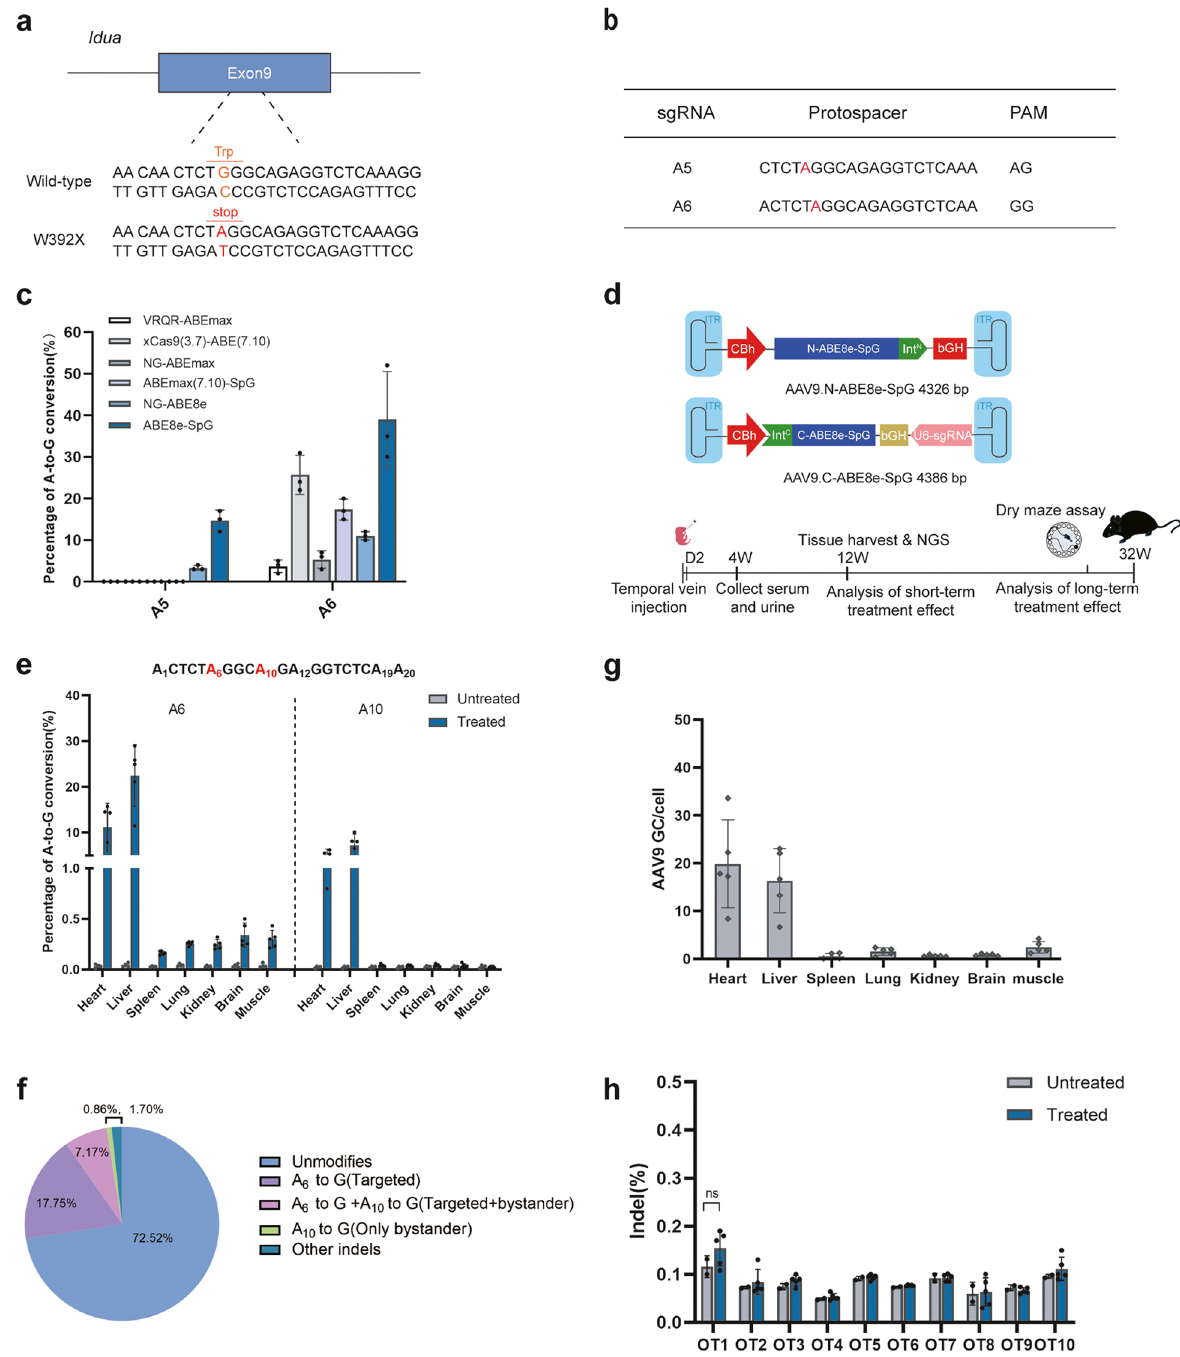
Fig. 1 In vitro screening of optimal ABE and sgRNA, and in vivo validation of pathogenic point mutation correction by AAV9-ABE. a The Idua- W392X mice has a homozygous G•C to A•T nonsense mutation in exon 9 of the Idua gene, changing tryptophan (orange) to a stop codon (red). b sgRNA-A5 and sgRNA-A6 were designed to target mutation site (red letter) in the editing window of ABEs. c Sanger sequencing analysis of correction efficiency of different ABE and sgRNA combinations in mutant cell lines. d Schematic diagram of the genomes of two AAV viral vectors encoding split-intein ABE8e-SpG (top) and a summary of the in vivo experiments (bottom). e The correction efficiency of pathogenic mutations in mouse tissue genomic DNA was detected by NGS. Untreated MPS IH mice ( n 4) were included as control. Treated MPS IH mice ( n 5). Mean SD = = ± are shown. f The pie charts show the average composition of allele variants at the DNA levels in liver tissues of a representative treated MPS IH mice. g Quantitative analysis of viral genome copy number in various tissues by qPCR. Mean SD are shown. h NGS analysis of the top 10 potential ± off-target sites in liver DNA samples. Untreated MPS IH mice ( n 2) were included as control. Treated MPS IH mice ( n 5). Mean SD are shown. = = ± One-way ANOVA with Tukey’s post-hoc test, ns =